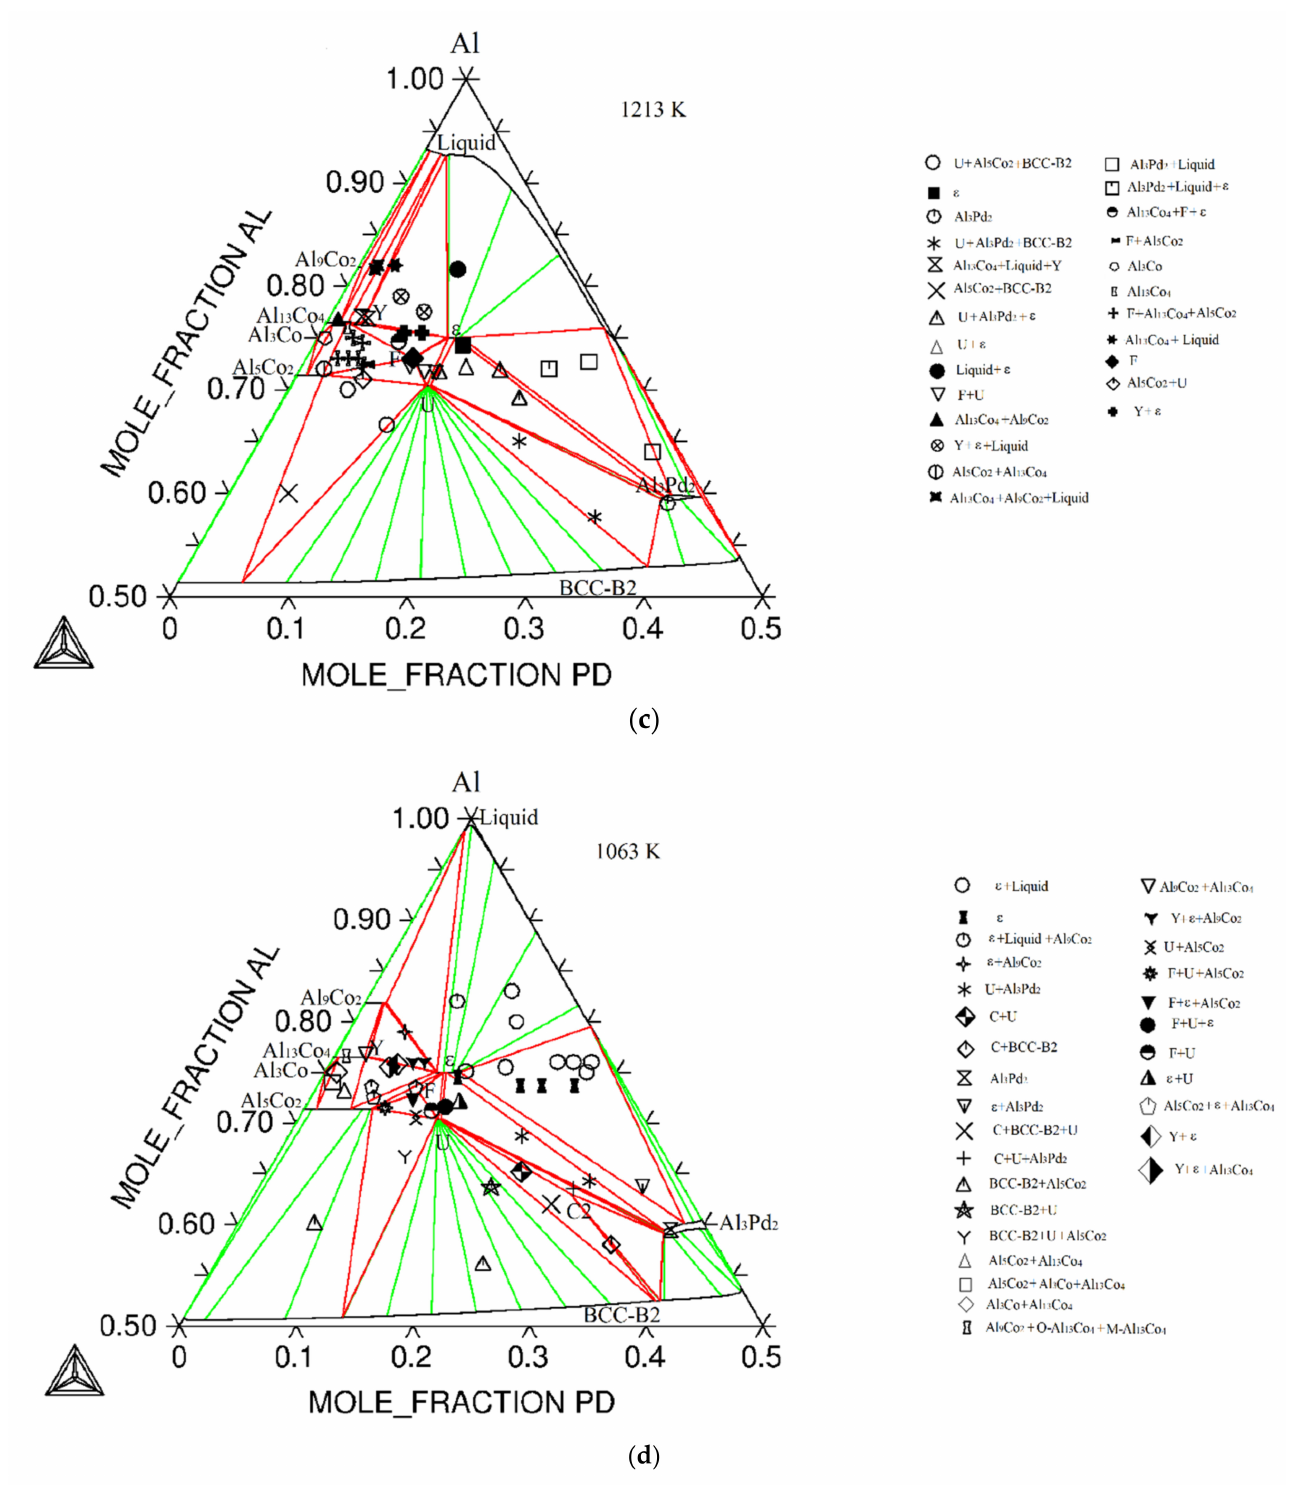
Figure 5. Calculated Al-rich corner of the isothermal section of the Al–Co–Pd system with experimental data points from the literature [10] ( a ) 1323 K; ( b ) 1273 K; ( c ) 1213 K; ( d ) 1063 K. At 1063 K (Figure 5d), the Al 3 Pd+Al 3 Pd 2 +liquid equilibrium was calculated. The equilibrium is not presented in a phase diagram according to Yurechko et al. [10]. Yurechko presented homogeneity range of the Al 3 Pd phase from binary system (Al 3 Pd) to 73.7Al- 11.1Pd-15.2Co at this temperature. However, the Al 3 Pd phase forms by peritectic